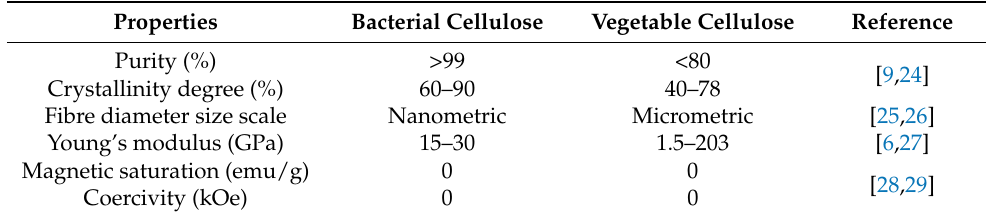
Table 1. Comparison of properties of bacterial cellulose (BC) and vegetable cellulose (VC).